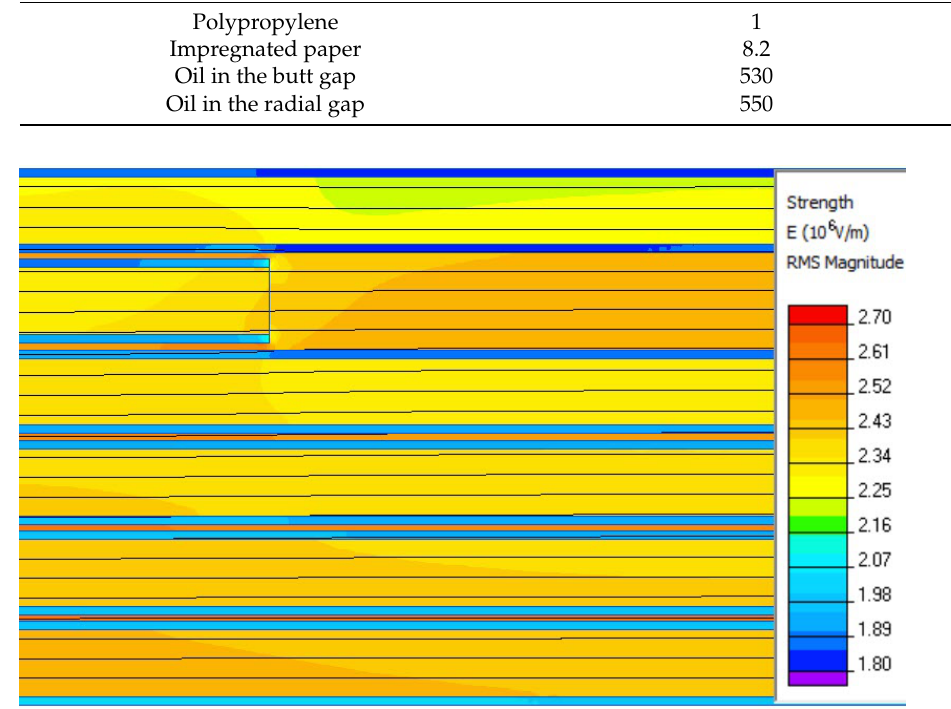
Figure 5. Electric field in the insulation near the longitudinal oil-filled gap.